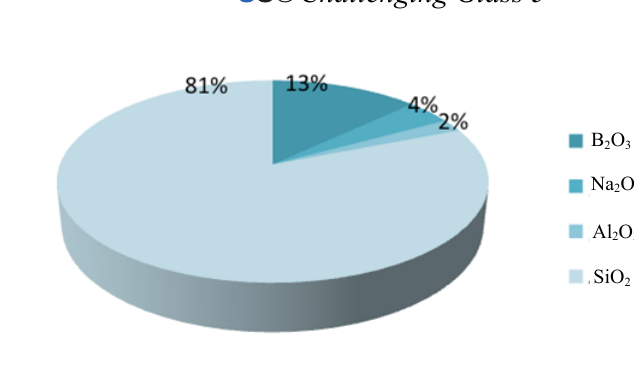
Fig. 1 Chemical composition of Borofloat 33